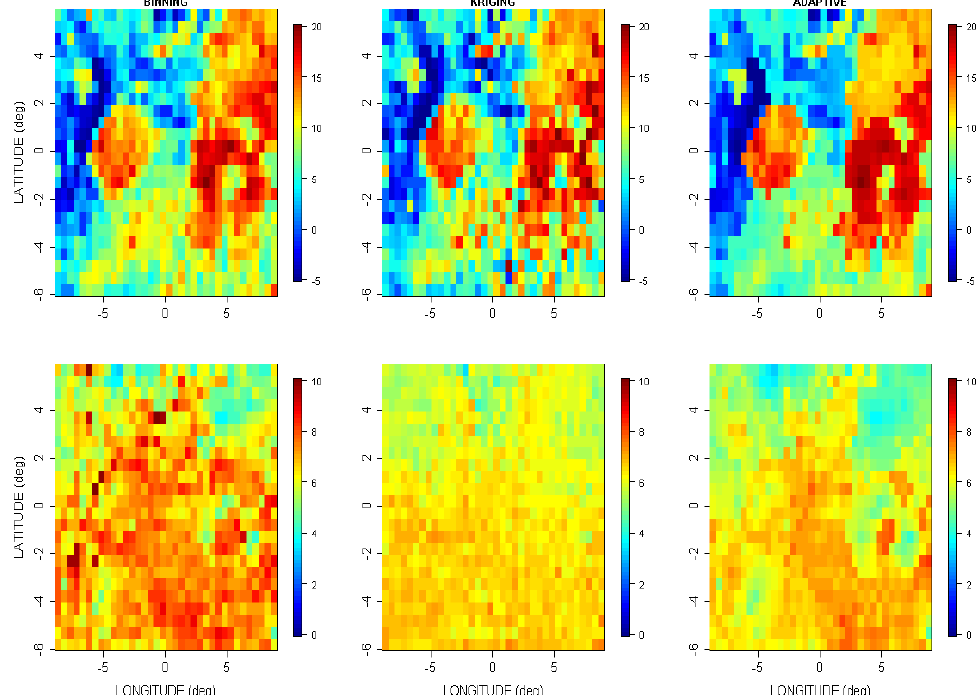
Figure 5. Top row: Mean nadir σ ◦ of a test area over SE Asia using data from one week in July. Grid resolution is 0.5 ◦ ; latitude and longitude are relative to the area’s center. On the left is the result of binning all measurements within specified space and time ranges. In the center is the standard deviation resulting from kriging, in place of binning. On the right are the results for our implementation of the Meneghini and Kim [14] adaptive approach. Bottom row: Same as top row but standard deviation (SSD) instead of mean.